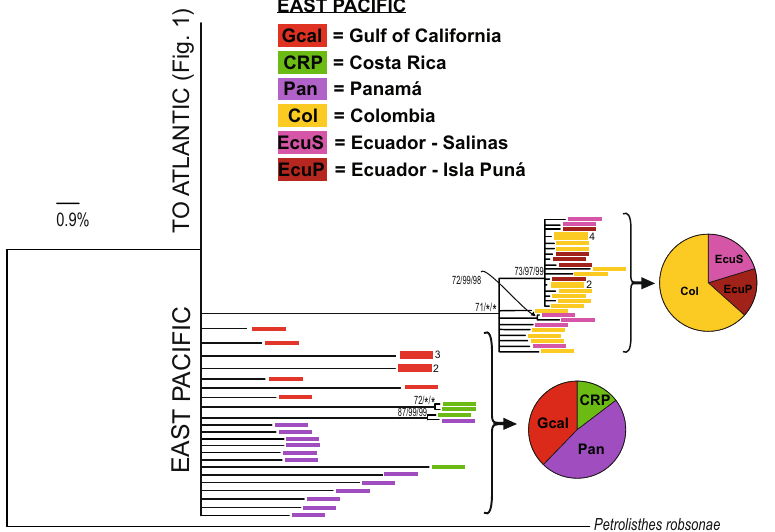
Figure 2. Continuation of phylogenetic tree shown in Fig. 1. Notation as in Fig. 1.